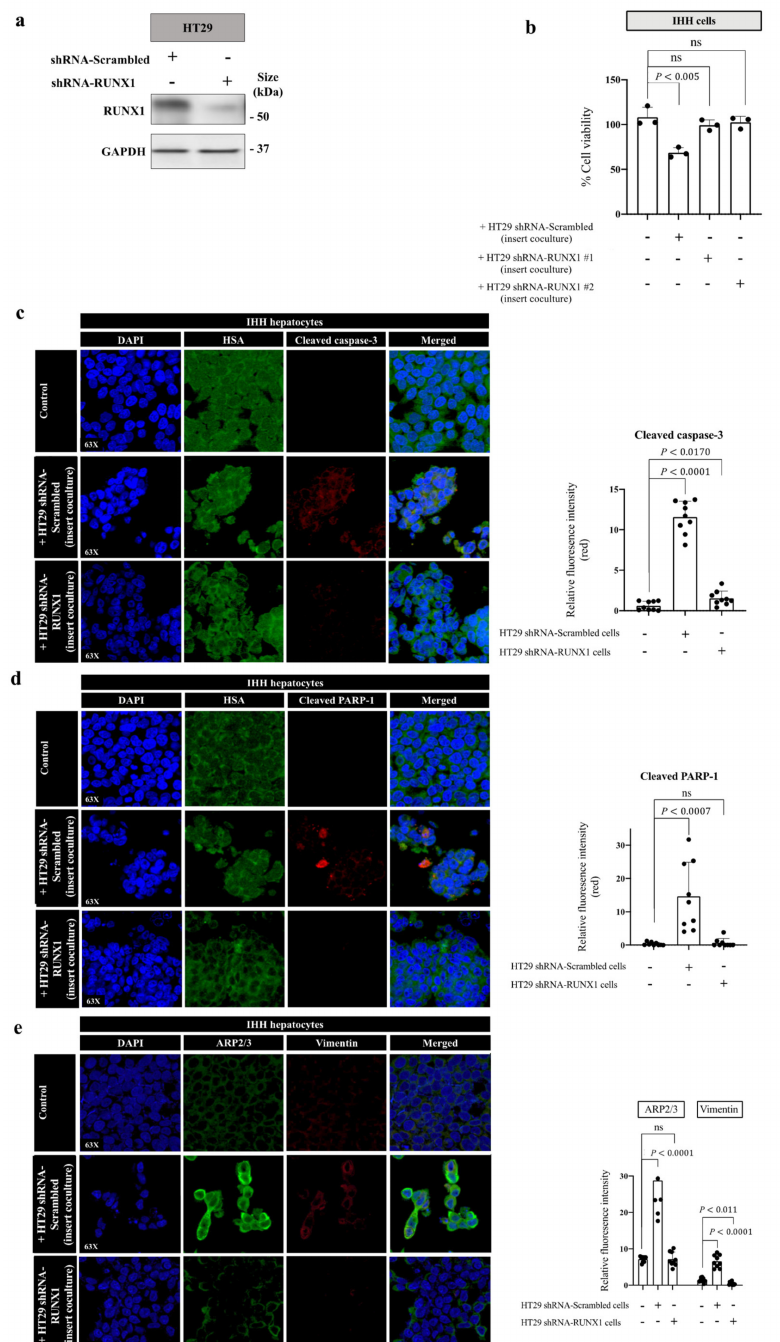
Figure 5. The expression of RUNX1 in cancer cells is crucial for interactions between cancer cells and hepatocytes. ( a ) represents immunoblotting of RUNX1 in HT29 cancer cells expressing either shRNA-scrambled or shRNA-RUNX1. ( b ) Cell viability was assessed with MTT assay in IHH cells cocultured with HT29 colorectal cancer cells expressing shRNA-scrambled or shRNA-RUNX1. ( c – e ) represent co-IF of IHH hepatocytes cocultured with HT29 cancer cells expressing shRNA control or shRNA against RUNX1. The cells were stained with HSA and cleaved caspase-3, HSA and cleaved PARP-1, or ARP2/3 and vimentin, respectively. Average pixel intensity was measured from three randomly selected areas for each sample. The right panels represent the quantification of positive pixels. Results are representative of 3 independent experiments. The bar chart shows mean values ± SD. ns = Not